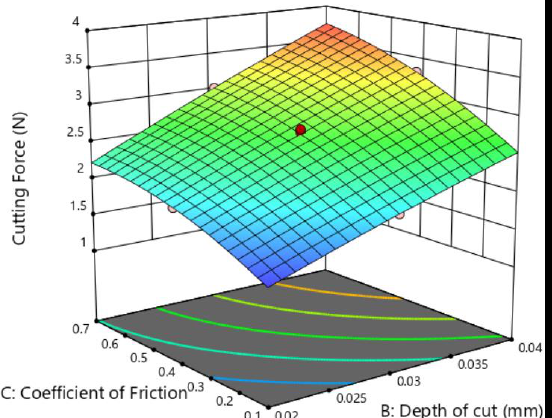
Figure 10. Response surface of the depth of cut and coefficient of friction on cutting force. Micromachines 2021 , 12 , x FOR PEER REVIEW